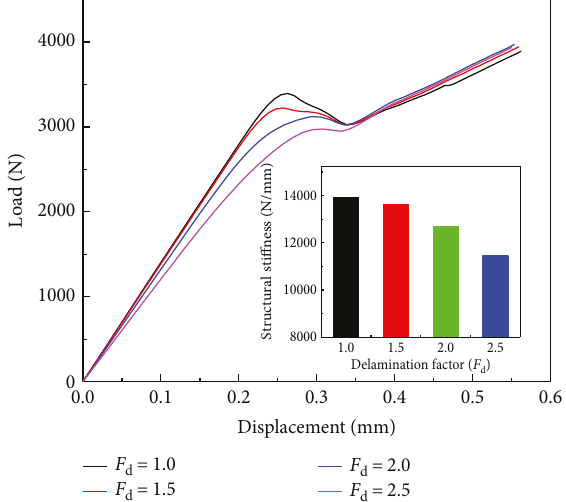
Figure 10: E ff ect of delamination scale on bearing capacity and structural sti ff